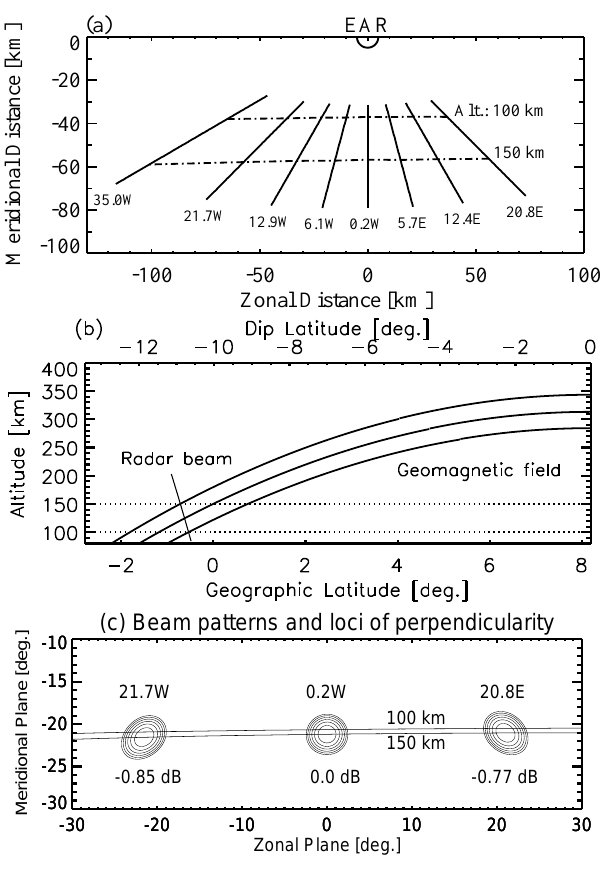
Fig. 1. (a) Radar beam directions projected on the horizontal plane. (b) Latitude-altitude cross section of 0.2W and geomagnetic field along a magnetic meridian. (c) Beam patterns of three directions (20.8E, 0.2W and 21.7W) and loci of perpendicularity at altitudes of 100 km and 150 km. Values in dB are peak power at boresights relative to 0.2W. Contours are drawn every 1 dB.